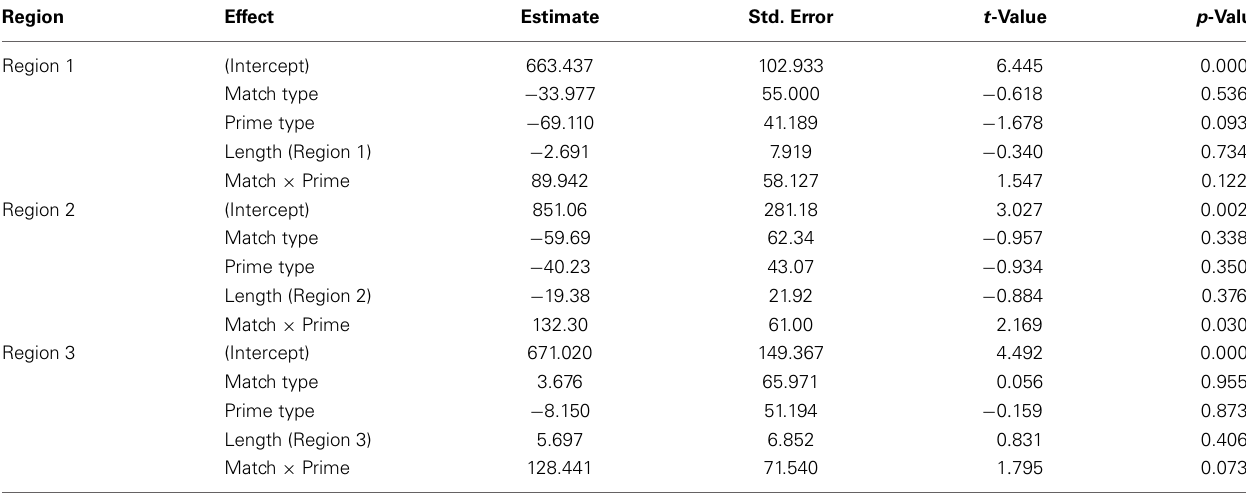
Table 4 | Model estimates and statistics for the Metaphorical sentences, Experiment